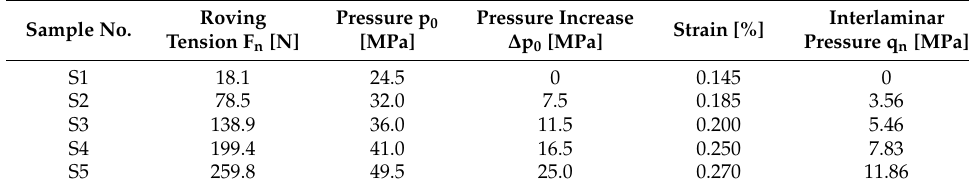
Roving Tension F n [N]